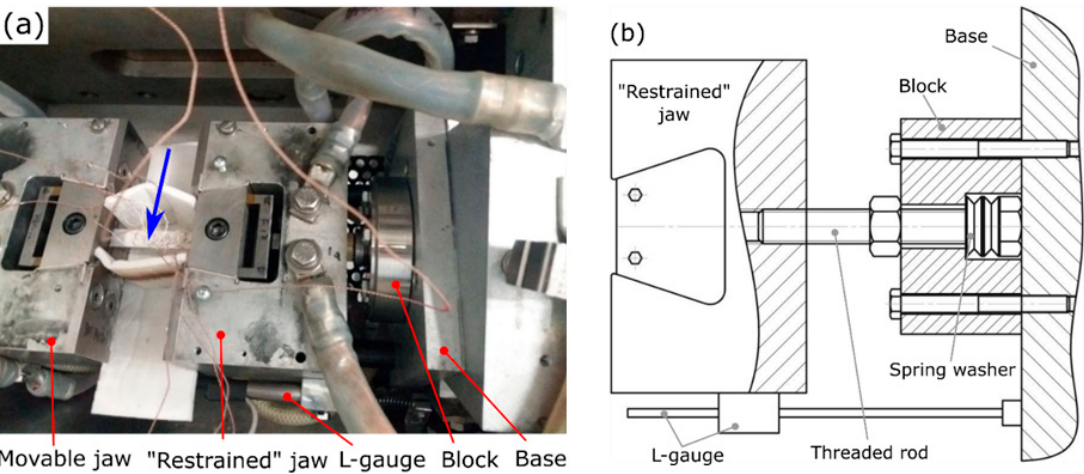
Figure 4. The tensile setup in the low-force cell module of the Gleeble unit used to conduct a tensile test at near-solidus temperatures: ( a ) general view (blue arrow indicating the tensile sample), and ( b ) schematic of the assembly that was modified to convert the displacement of the “restrained” jaw under tensile loading into the force.